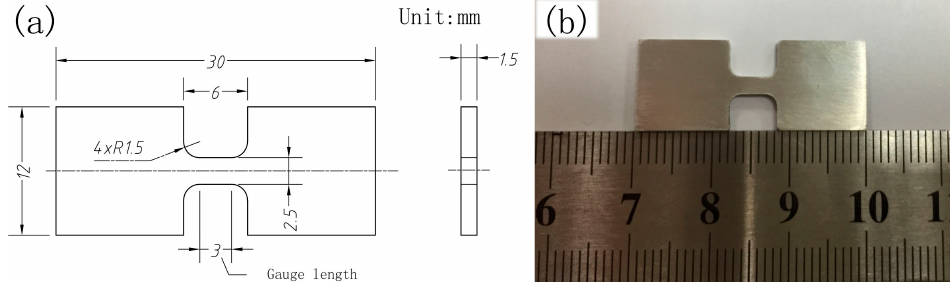
Figure 12. ( a ) Dimensions and ( b ) photograph of specimens for tensile test.